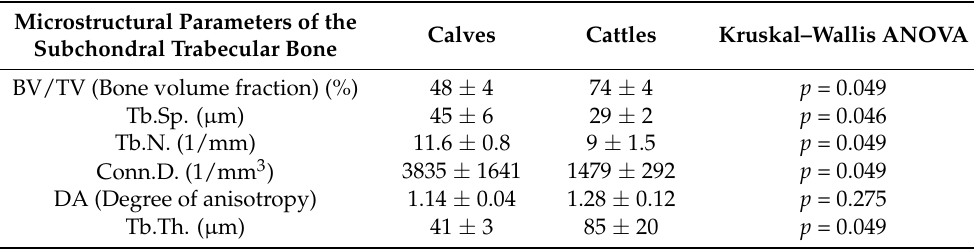
Figure 1. Bone cylinders were punched out from the medial condyle of the distal femur using a bone trephine drill (6.00 mm inner diameter). Cylinders extracted from K1 site on the medial condyle were used for micro-CT analysis, while K2 and K3 samples were selected to perform histomorphometry and EDX evaluations, respectively (A) . The samples were immediately stored in PBS after the extraction (B) . Osteochondral biopsies are shown for calf ( C ) and cattle ( D ). Histological sections following Masson – Goldner staining are illustrated for calves ( E ) and cattle ( F ). “ AC ” , “ CC ” , and “ SCBP ” denote articular cartilage, calcified cartilage, and subchondral bone plate, respectively. The microCT image reconstructions are shown in the bottom row. Calves ( G ) demonstrated a finer and thinner trabecular pattern with many small cavities in comparison with cattle ( H ). Table 1. Quantitative micro-CT analysis of the subchondral trabecular bone at the medial condyle of distal femur.